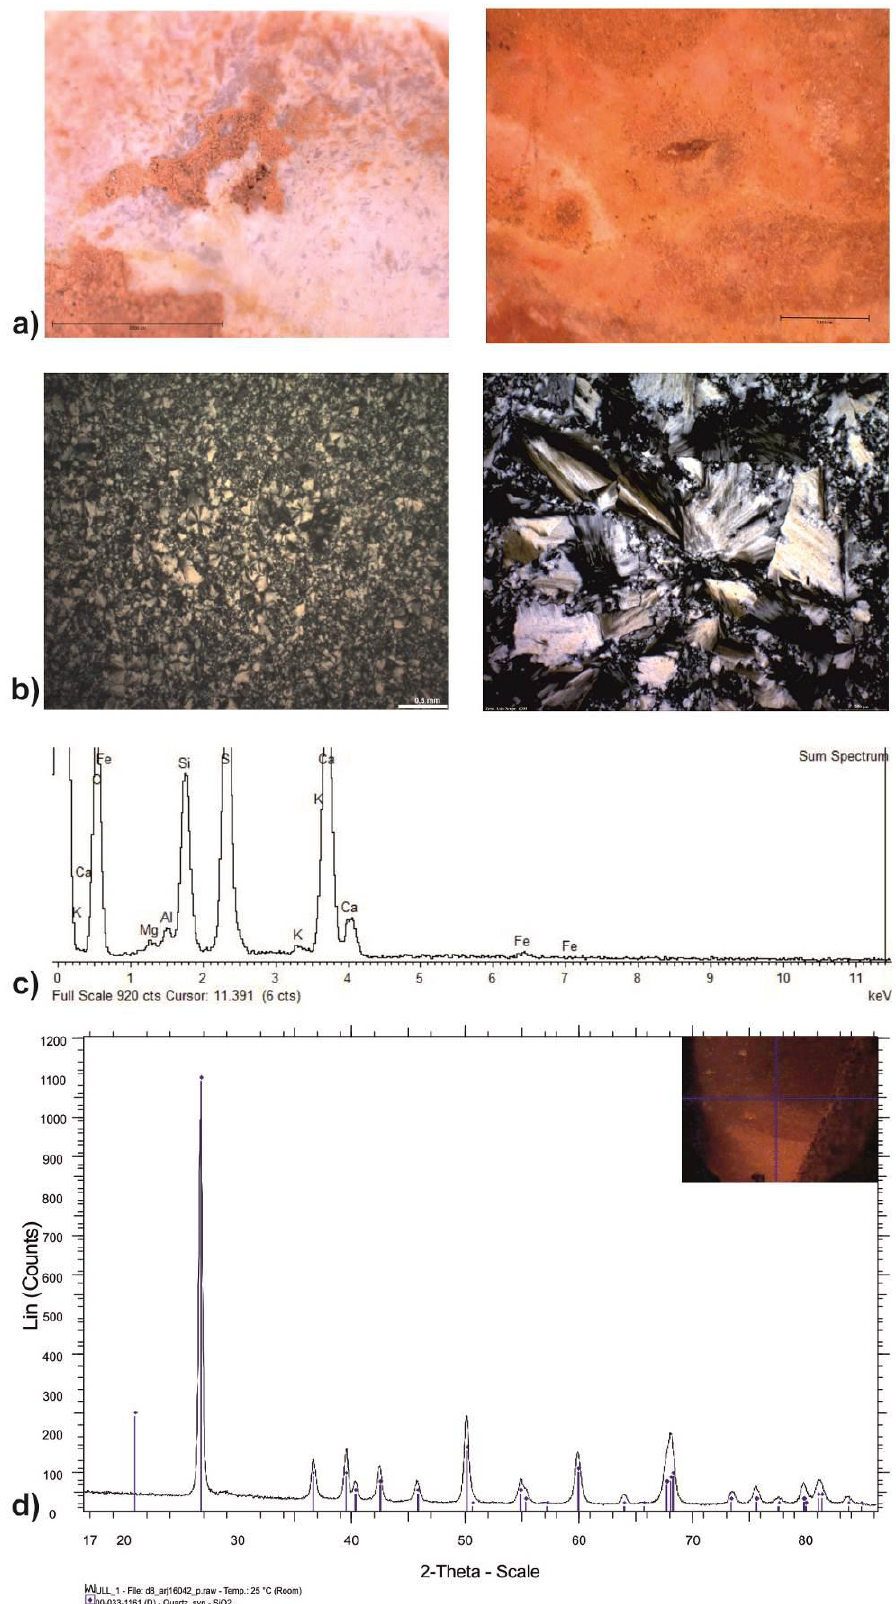
Figure 6. a) Stereoscopic microscope observations with evidences of gypsum relicts. b) Thin sections with crossed polariser showing microquartz (left) and length-slow chalcedony and a gypsum crystal (right). c) ESEM chemical component Spectrum. d) μ-XRD of the indicated